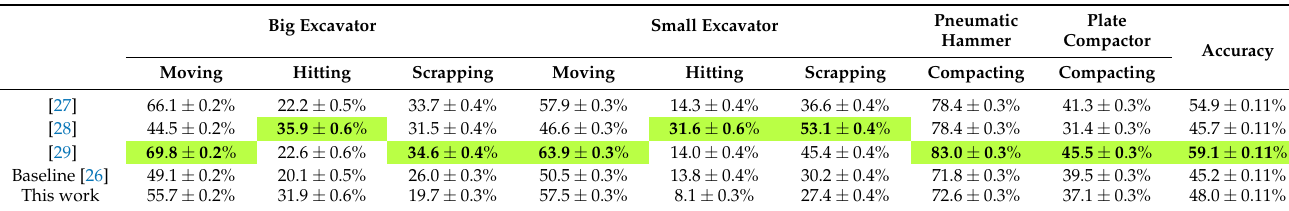
Plate Hammer Compactor Accuracy